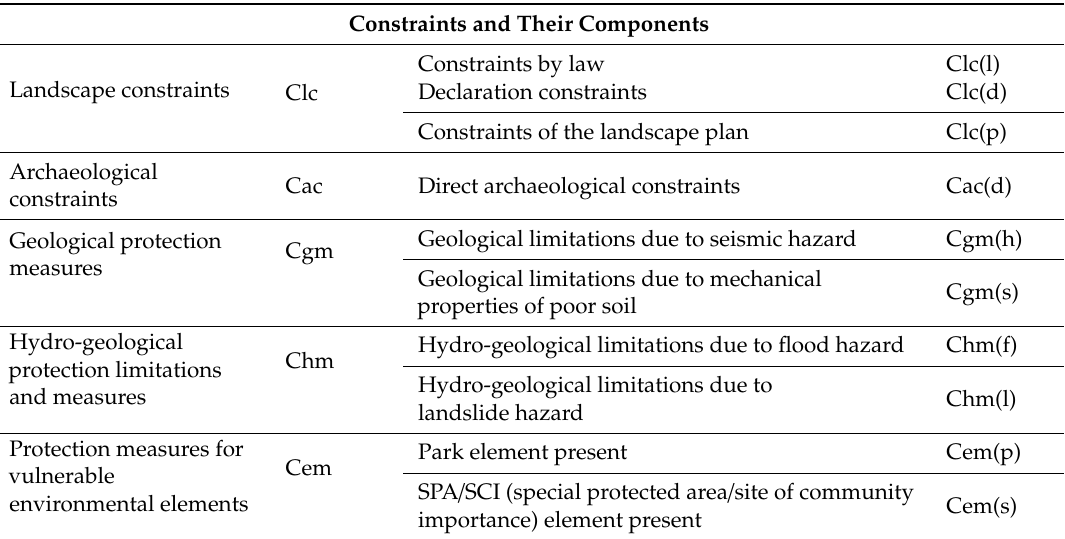
Table 1. Constraints and their components in the Italian